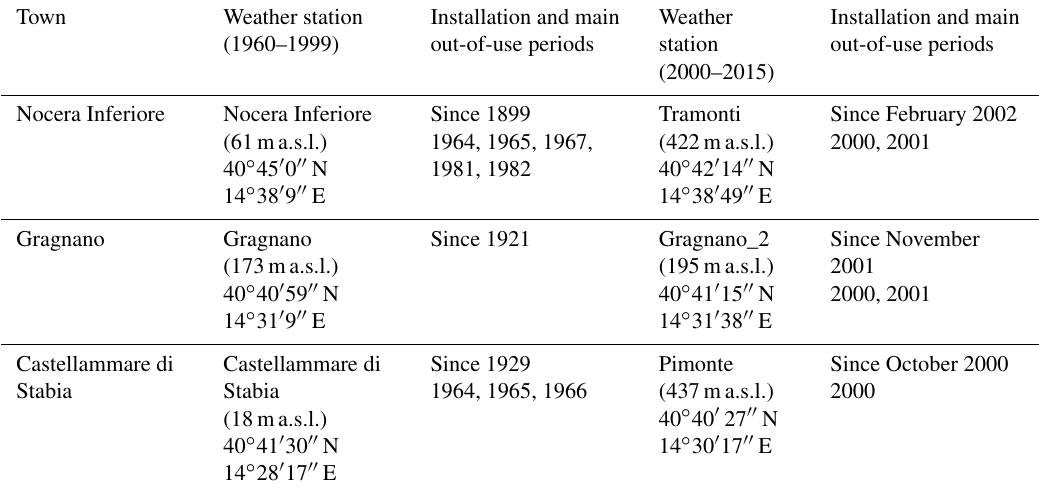
Table 1. Weather stations used in the compilation of datasets for Nocera Inferiore, Gragnano, and Castellammare di Stabia and their locations, installation times, and main out-of-use periods.